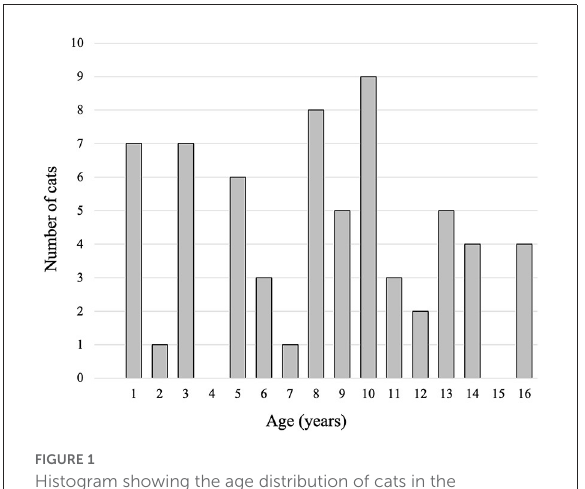
FIGURE1 Histogram showing the age distribution of cats in the present study.